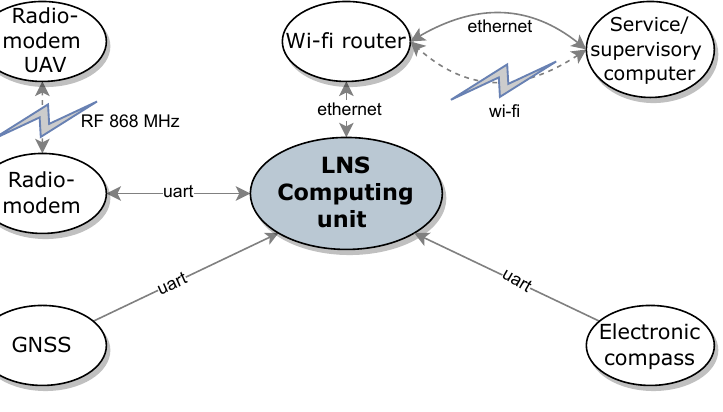
Figure 7. Diagram of LNS